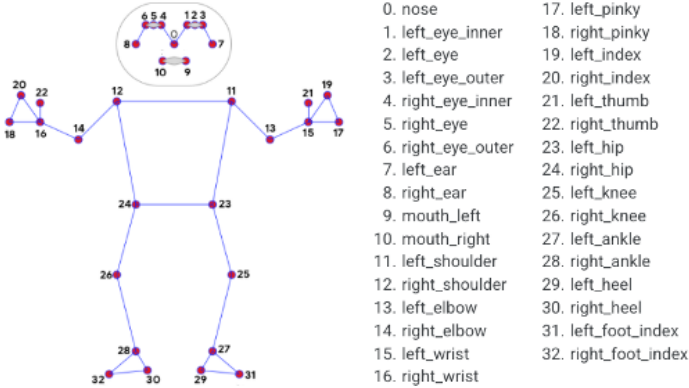
Figure 2. MediaPipe Keypoints.